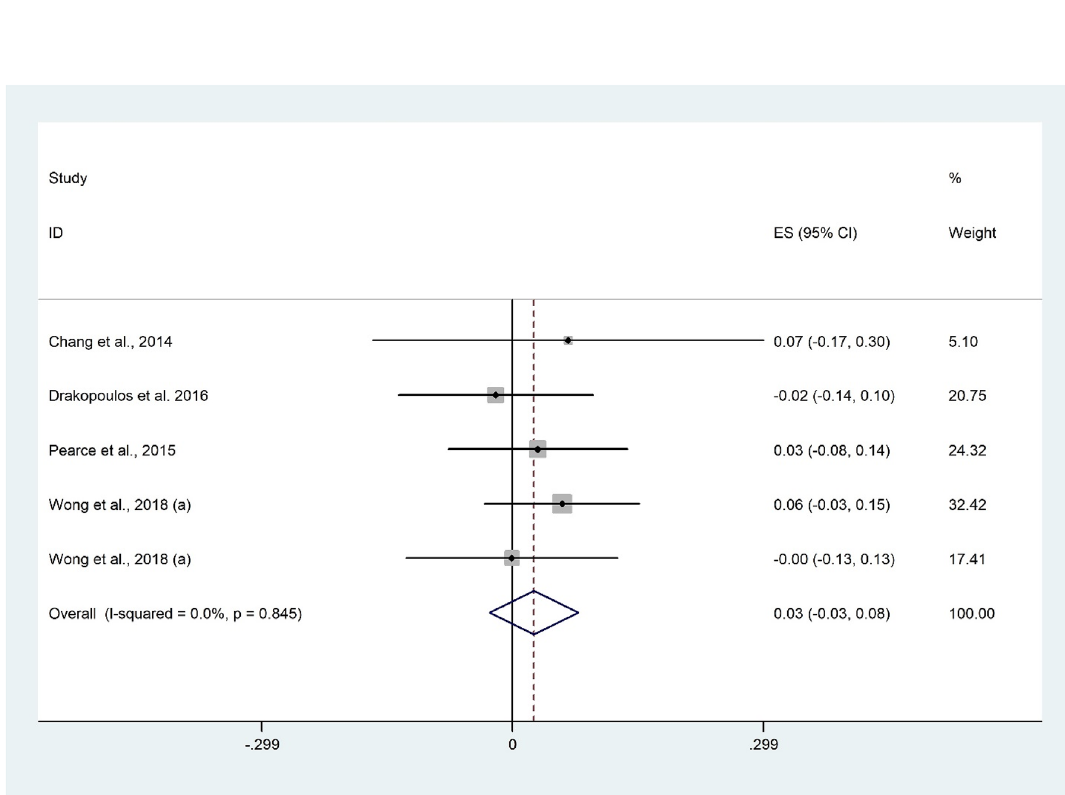
Figure 6. Forrest plot of the correlation between AFC and 25(OH)D